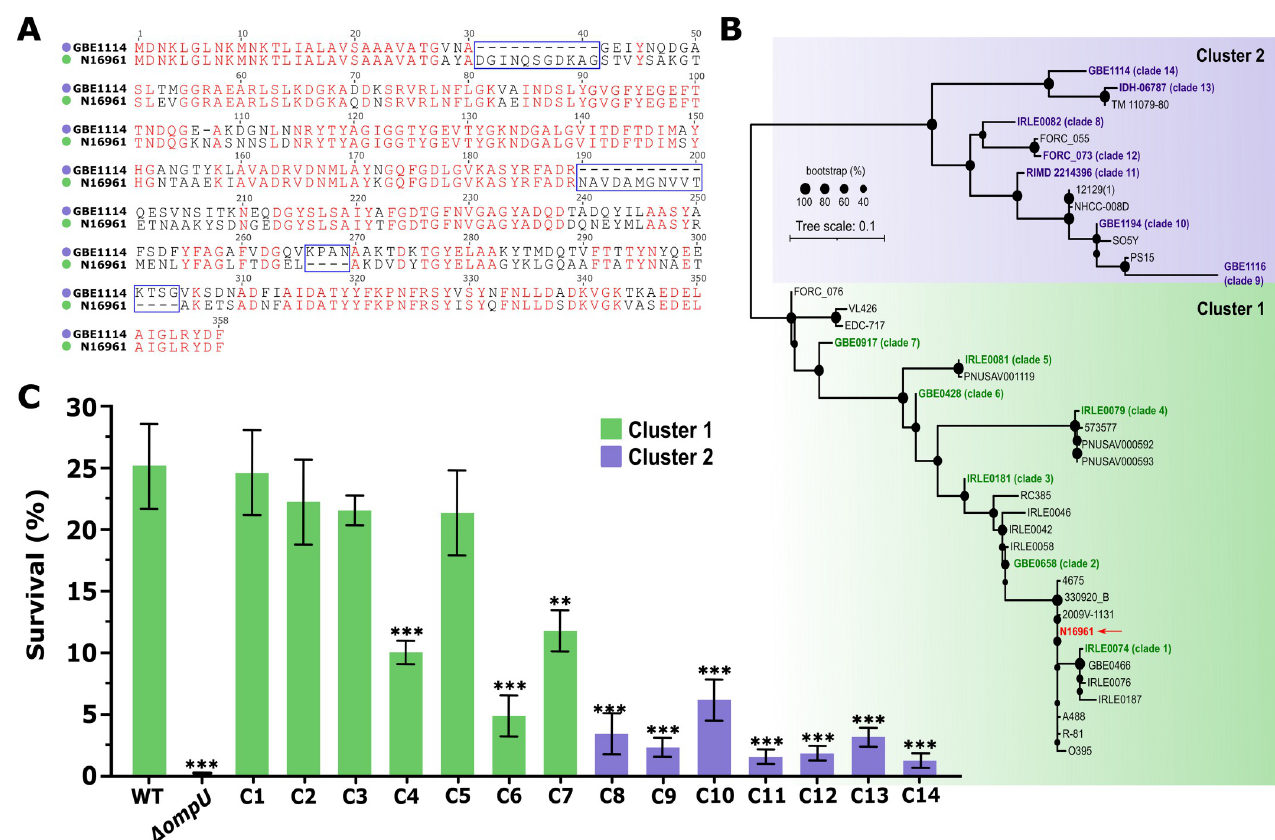
Fig 1. OmpU forms two highly diverse phylogenetic clusters. (A) Sequence alignment of the ompU alleles from strains V . cholerae N16961 and GBE1114. (B) OmpU has diverged into two major phylogenetic clusters. Red arrow indicates the clinical allele from N16961. Green and purple shading represent Cluster 1 and 2 respectively. (C) Survival of V . cholerae mutant strains encoding representative ompU alleles in the presence of 0.4% whole bile. Despite the large genetic differences between the alleles, strain survival in bile leads to convergent phenotypes. Error bars represent the standard deviation of the mean from at least three ( N � 3) independent replicates. Statistical comparisons were performed using one-way ANOVA analyses followed by a Dunnett’s multiple comparison test. All constructs were compared to the WT unless otherwise stated. * p < 0.05, ** p < 0.01, *** p < 0.001.